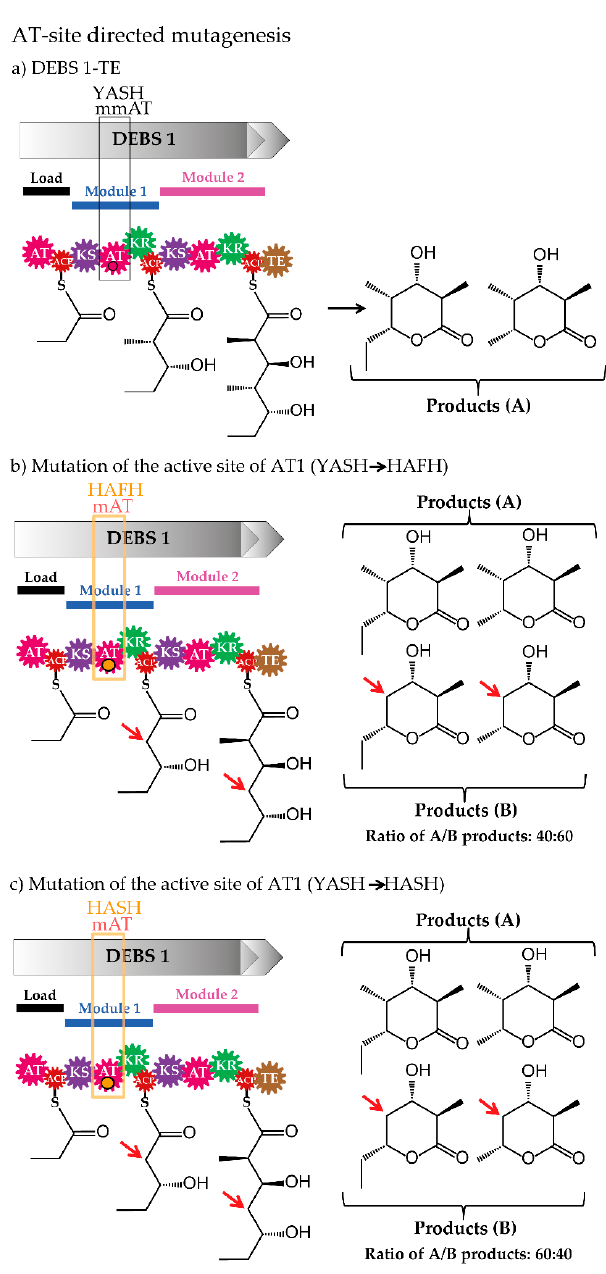
Figure 5. Examples of AT-site directed mutagenesis [60]. ( a ) The fusion of DEBS 1 and TE domain line (DEBS 1-TE) form the erythromycin assembly line. The strain containing the modified fusion DEBS 1-TE produced the respective triketide lactones (products A). ( b ) The fusion of DEBS 1-TE in which the AT of module 1 was modified by exchanging the specificity motif YASH (native, methylmalonyl-CoA) by the HAFH motif (malonyl-CoA). The strain Saccharopolyspora erythraea containing the modified DEBS-TE produced triketide lactones A and B (40:60). ( c ) The fusion of DEBS 1-TE in which the AT of module 1 was modified by exchanging the specificity motif YASH by the HASH motif (malonyl-CoA). The strain Saccharopolyspora erythraea containing the modified DEBS-TE produced triketide lactones A and B (60:40). Abbreviations: AT, acyltransferase; ACP, acyl carrier protein; KS, ketosynthase; KR, ketoreductase; TE, thioesterase; mmAT: AT loading methylmalonate; mAT: AT loading malonate.